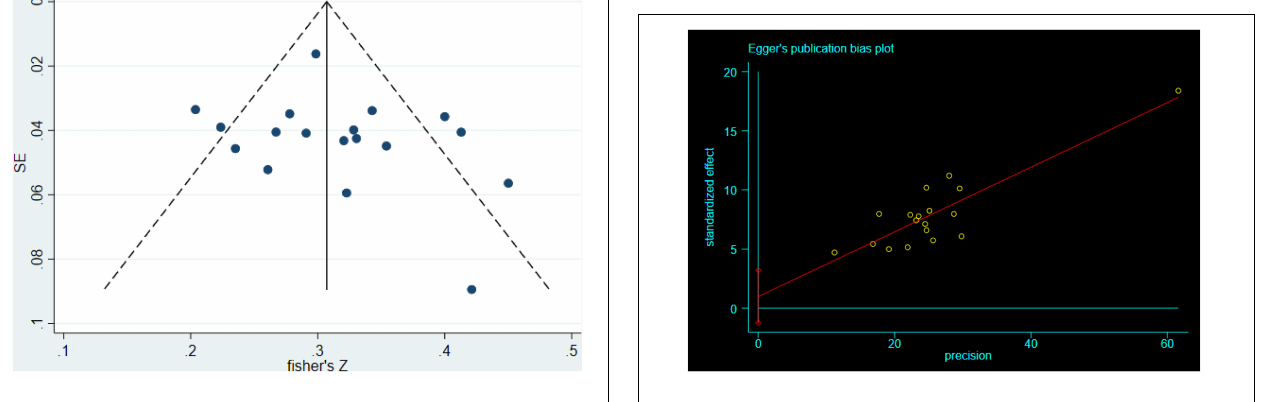
FIGURE 4 | Egger’s publication bias plot for the relationship between IAD and negative life